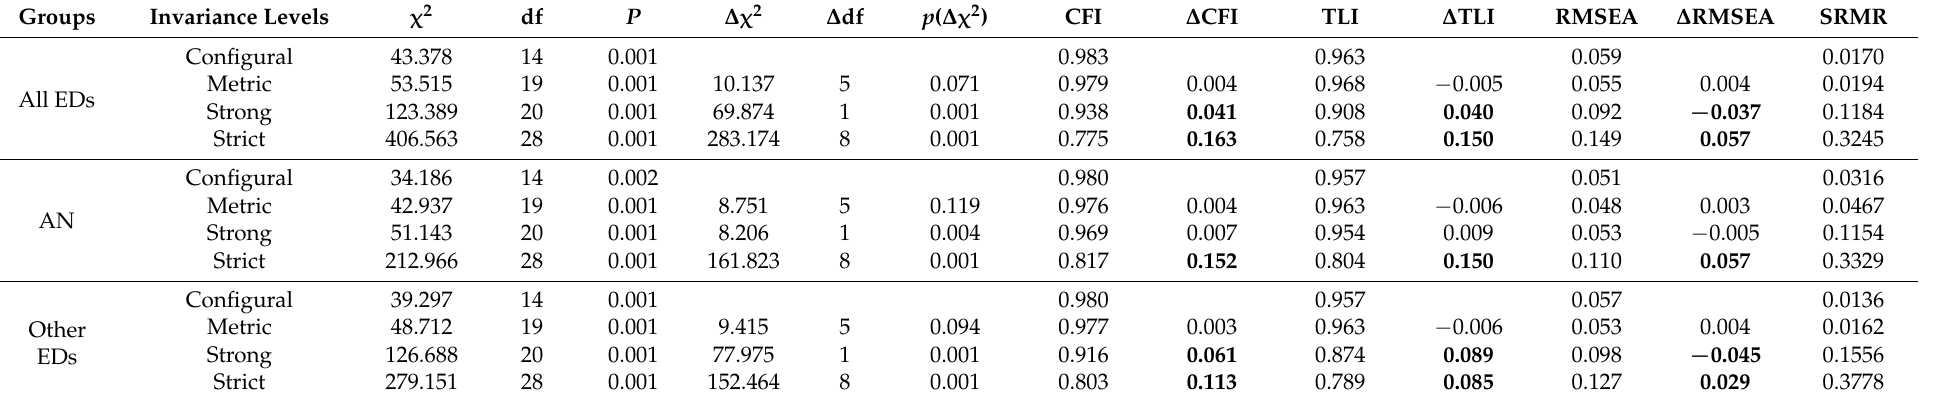
Table 8. Invariance of six-item IAT across female groups (women with EDs vs. healthy university